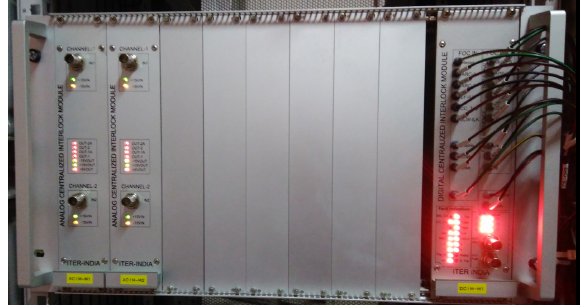
Fig. 15: Test Result of Spurious fault detection logic of CIM